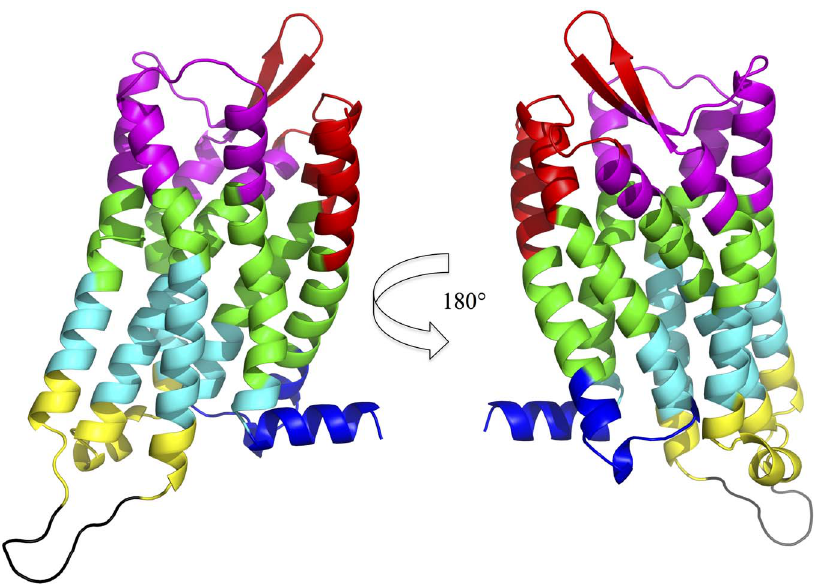
Fig. 9. Domain subdivisions of the m OR structure as obtained using the GeoStaS algorithm applied to the 0.5 m s all-atom MD simulation. The seven resulting domains are D1 (red), D2 (green), D3 (blue), D4 (cyan), D5 (pink), D6 (yellow), and D7 (black). doi:10.1371/journal.pone.0115856.g009 two lower values of the average RMSF per domain, 0.73 and 0.65 A˚ , respectively, correspond to those D2 and D4 domains, illustrating that they are the most rigid parts of the m OR structure. Moreover, these two domains are, along with D5, the most populated domains in term of residues, i.e., with 74 and 54 residues, The extracellular side of m OR also involves two dynamical domains, i.e ., D5 and